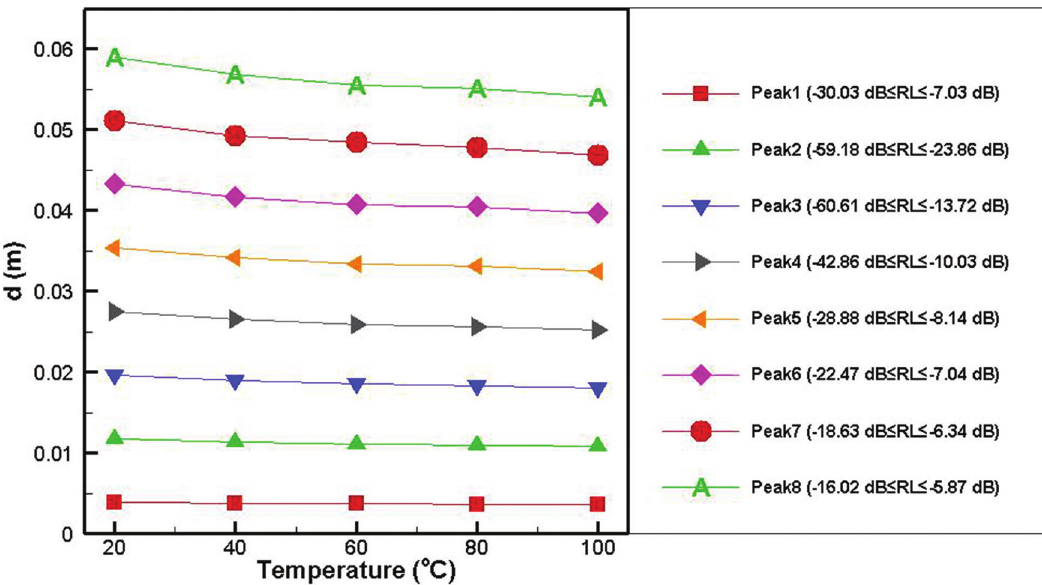
Fig. 5: Absorption peak positions in the RL of petroleum coke (10% moisture content) at various